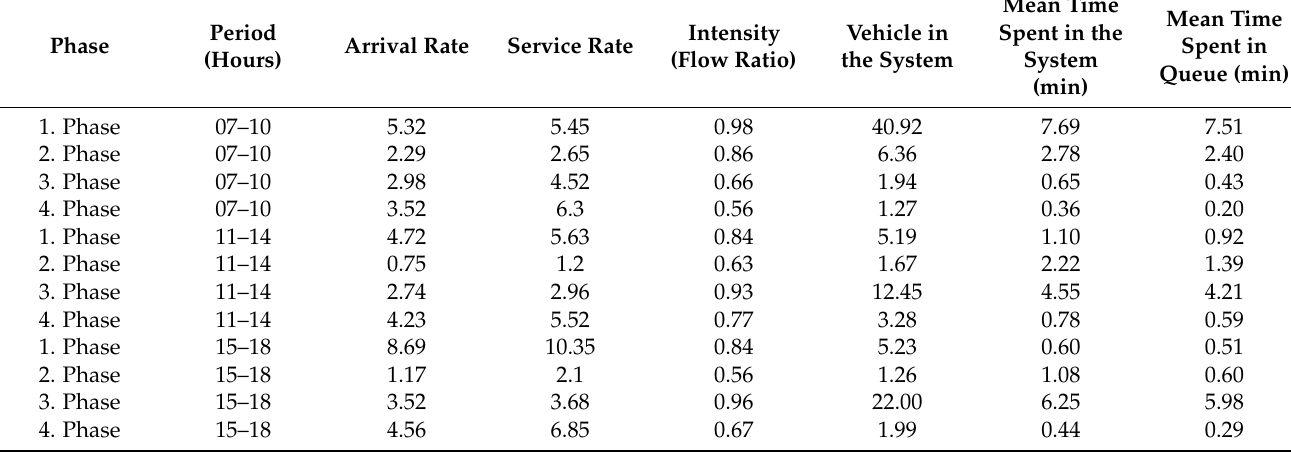
Table 11. The 10-day performance values of phases at Kartal–Sahilyolu